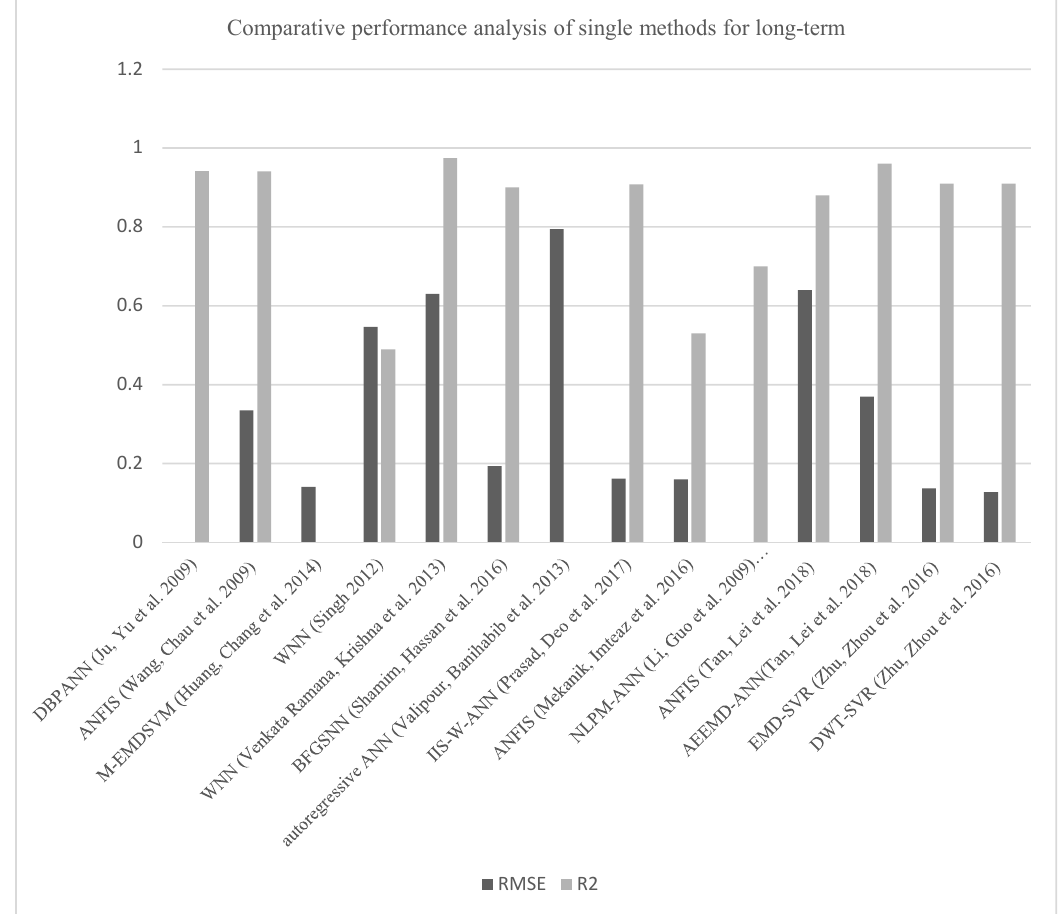
Figure 10. Comparative performance analysis of hybrid methods of ML for short‐term prediction.